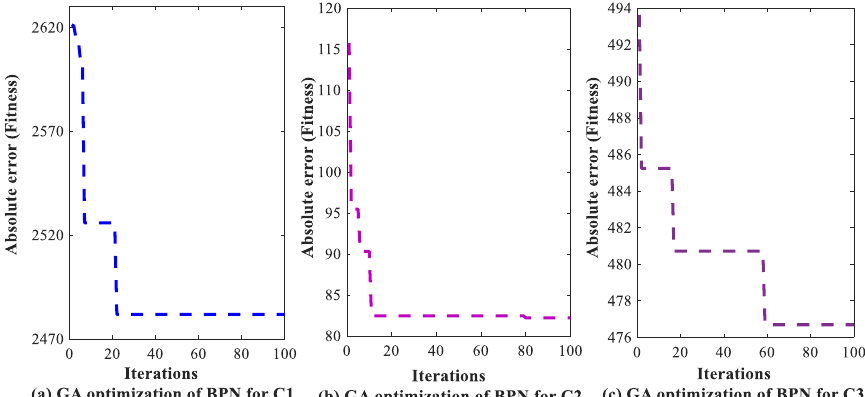
Table 4. All samples belonging to a category compete in the same way in training the GABPN geared to the category. Prediction models of GABPN were trained and tested for each category separately, while the aggregator BPN was trained with all the training samples and tested by all the testing samples. The GA parameters of population size, crossover probability, mutational probability, and the number of iterations of the three GABPNs were set to 100, 0.8, 0.05, and 100, according to some initial test. The convergences of GA for the initial parameter optimization of the three BPNs are illustrated in Figure 6. On the basis of the optimized parameters, the three BPNs were trained in parallel, and the output of the three prediction models was set into the aggregator BPN, with the membership degree of each sample obtained by FCM given in Figure 3. The predicted feeding panel of each sample can be determined according to the transformation described in Section 3.4, based on the reversely normalized output of the aggregator BPN.